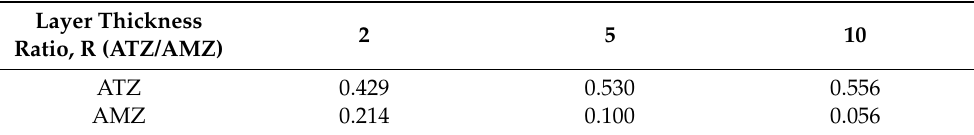
Table 2. Thickness parameters of Al 2 O 3 /ZrO 2 -layered ceramics with different layer thickness ratios (layer thickness unit: